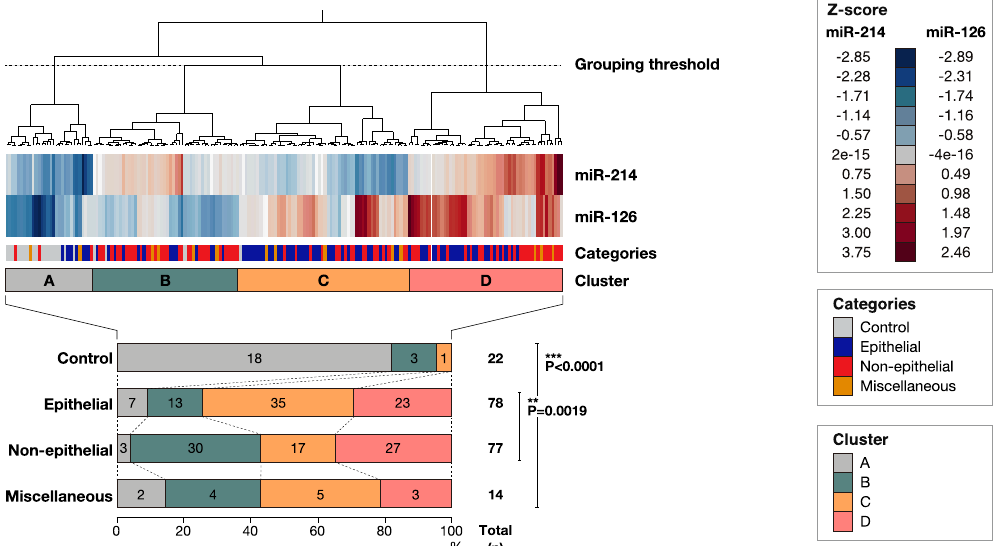
Figure 4. Heatmap and hierarchical cluster analysis of circulating miR-214 and -126 levels. Levels of circulating miR-214 and -126, showing different profiles between epithelial and non-epithelial groups. Heatmap and dendrogram were illustrated by Ward’s method using JMP software version 12.3. Samples were classified into 4 clusters based on the indicated threshold line. Relative levels ( − ∆ CT, relative to circulating miR-16) were normalised by the Z-score. Statistical significance between each category was calculated by the Chi-square test ( ** P < 0.01, *** P <